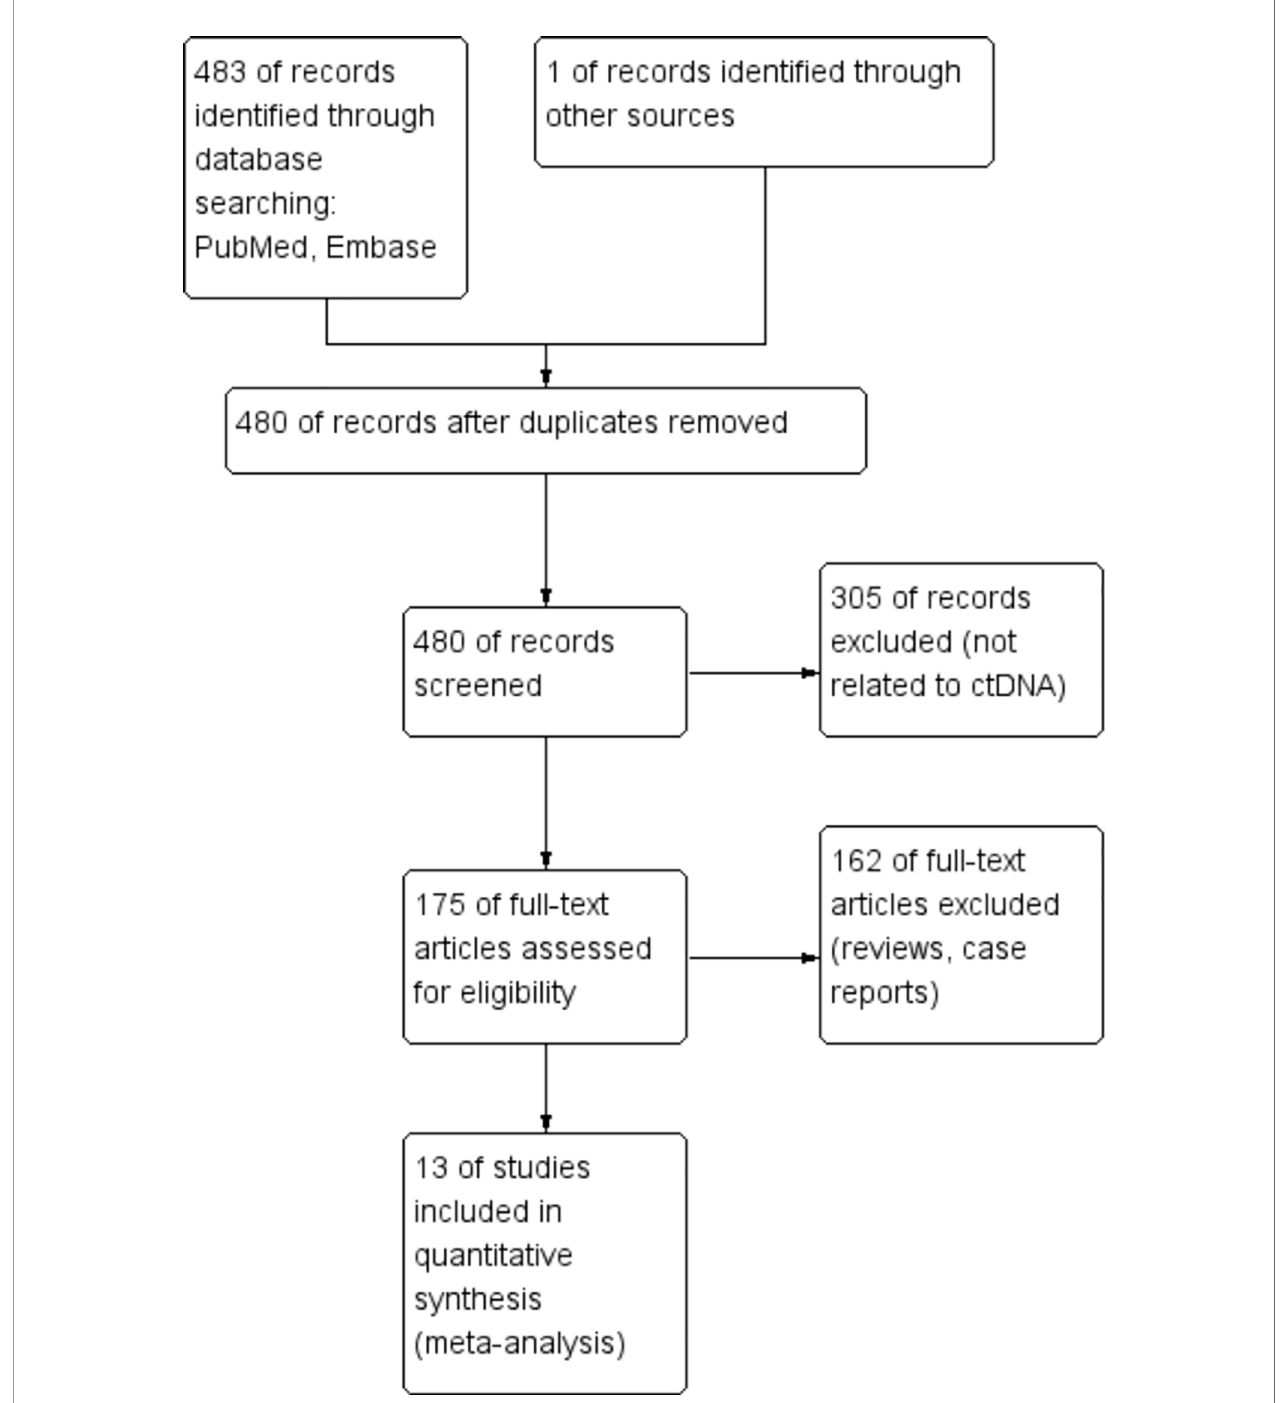
FIGURE 1 | Enrollment process of the included studies. The processes of identi fi cation, screening, eligibility, and inclusion are